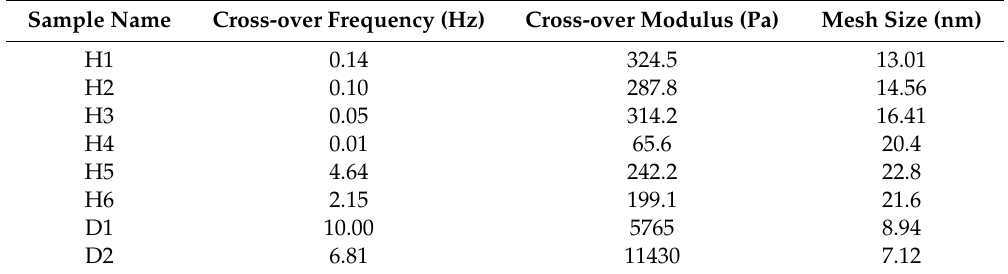
Table 2. Cross-over frequency and modulus, mesh size for all prepared